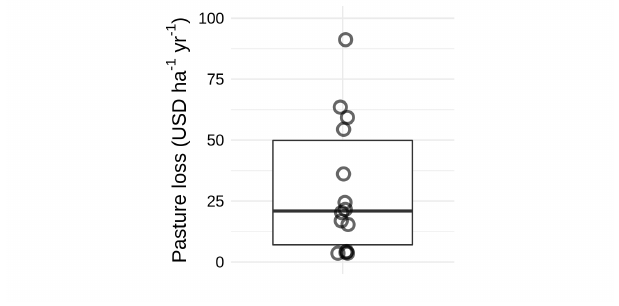
Fig. 4. The economic impact of elk-induced pasture loss for beef and dairy producers on the North Coast.